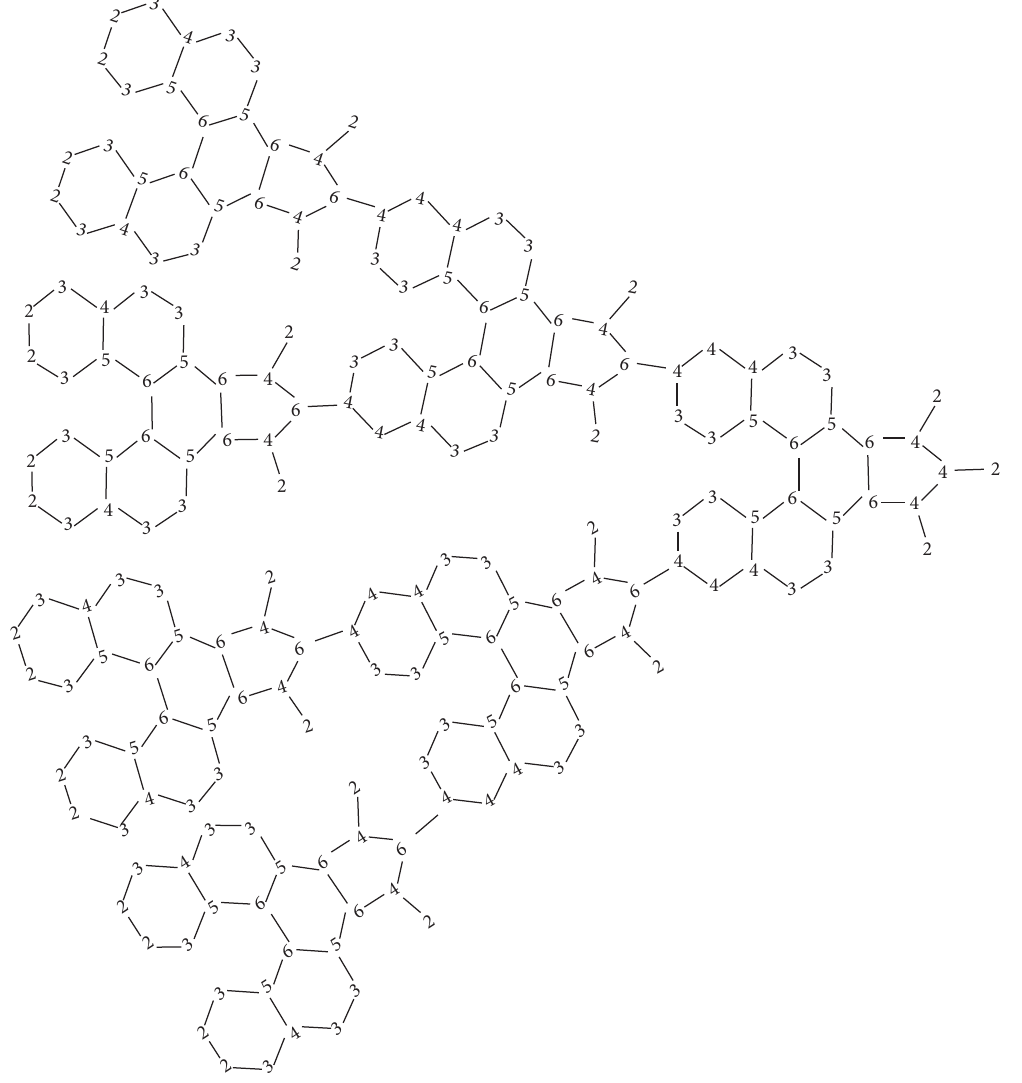
Figure 9: D [ 3 ] along with the CN of each vertex. 2